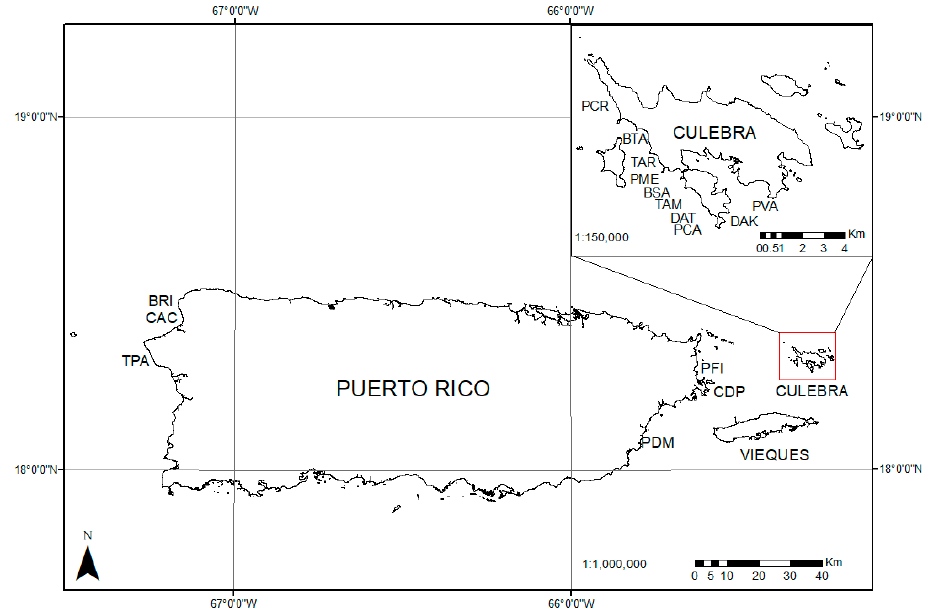
Figure 1. Spatial distribution of the sampling locations. Refer to the list of locations in the Method- ology for acronyms.